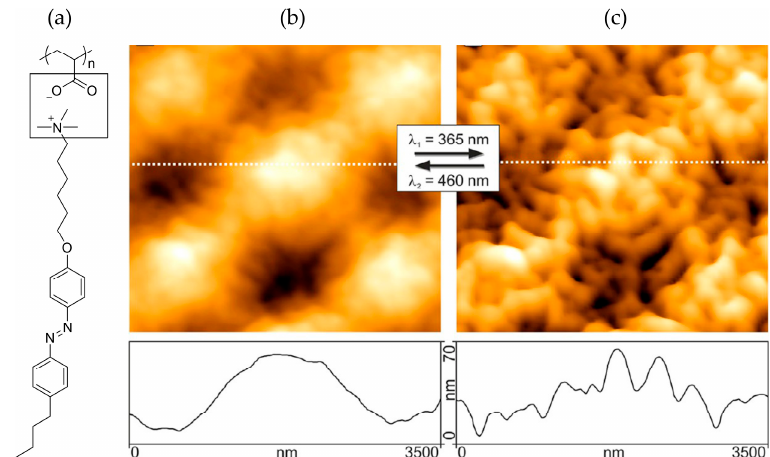
Figure 8. ( a ) Chemical structure of the supramolecular polymer brush used in reference [93]; ( b , c ) AFM micrographs of the in-situ recorded topography switching of a chessboard shaped SRG in a supramolecular azobenzene polymer brush complex during further UV irradiation ( c ) and after subsequent illumination with blue light ( b ). Reproduced from [93].